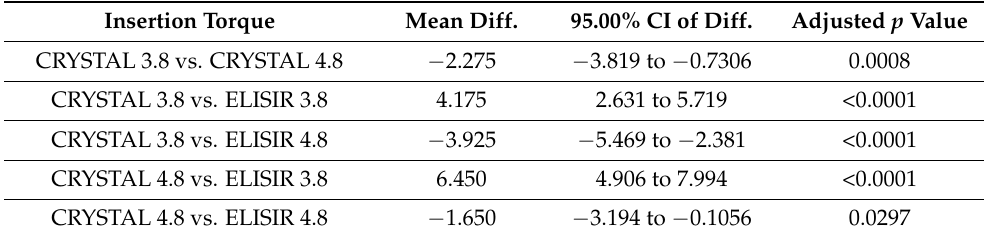
Table 2. ANOVA post-hoc of insertion torque comparisons of the study groups.